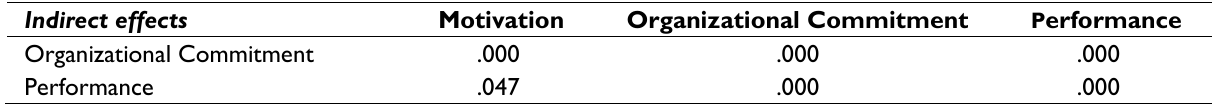
Table 5. Standardized Indirect